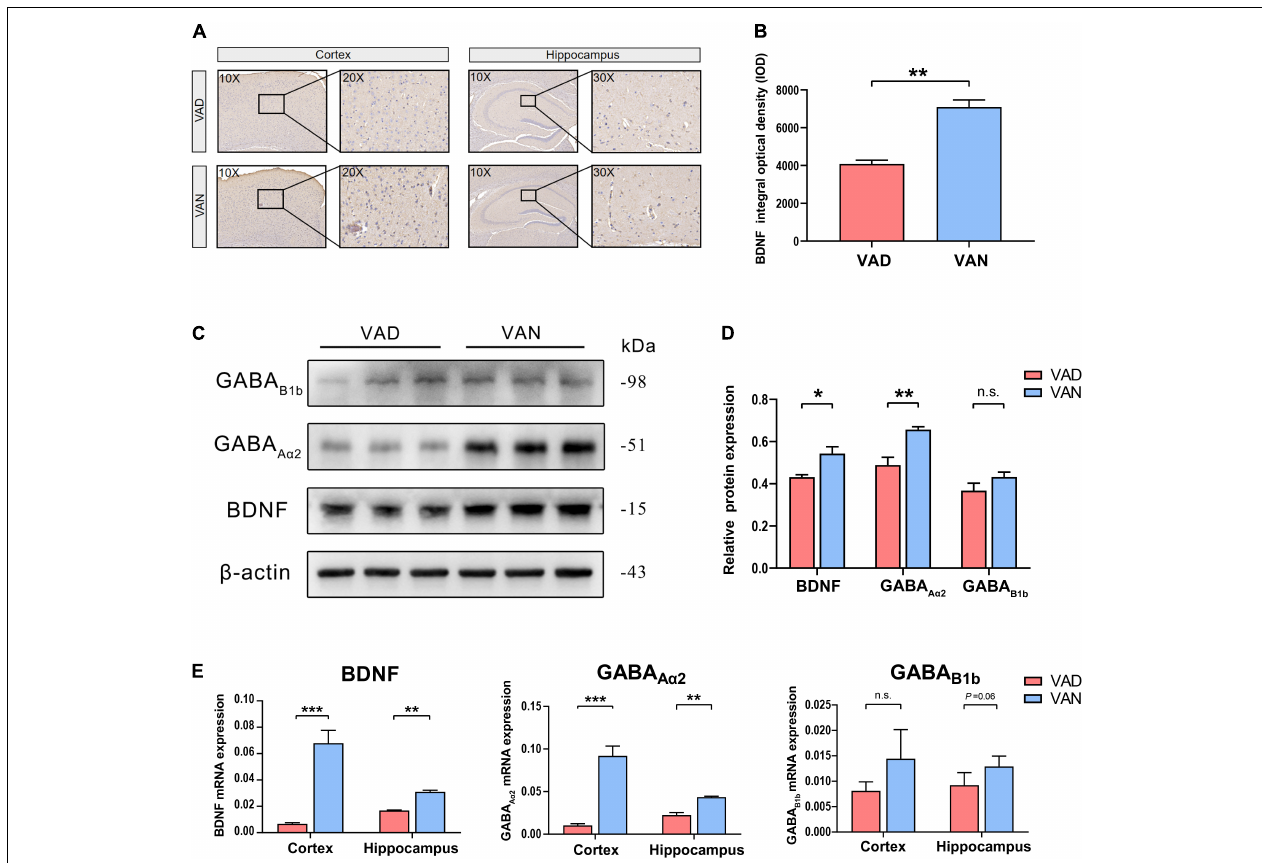
FIGURE 9 | Consumption of the VAD diet for 45 weeks reduced the expression of brain-derived neurotrophic factor (BDNF) and the γ -aminobutyric acid (GABA) receptors in the cortex and hippocampus of the APP/PS1 transgenic mice. (A) The IHC images (10 × , 20 × , and 30 × ) showing the staining of the BDNF in the brain. (B) Quantification of the BDNF level in the brain of the mice in the IHC assay. (C) The WB images showing the expression of BDNF, GABA A α 2 , and GABA B1b in the cortex of the APP/PS1 mice fed with either VAD or VAN. (D) The BDNF, GABA A α 2 , and GABA B1b were quantitated according to the band density and normalized against the levels of β -actin. (E) RT-qPCR analysis of the expression of BDNF, GABA A α 2 , and GABA B1b genes in the cortex and hippocampus of the APP/PS1 mice. VAD, vitamin A deficiency diet; VAN, vitamin A normal diet. n = 3 per group. ∗ P < 0.05, ∗∗ P < 0.01, ∗∗∗ P < 0.001, and n.s.,